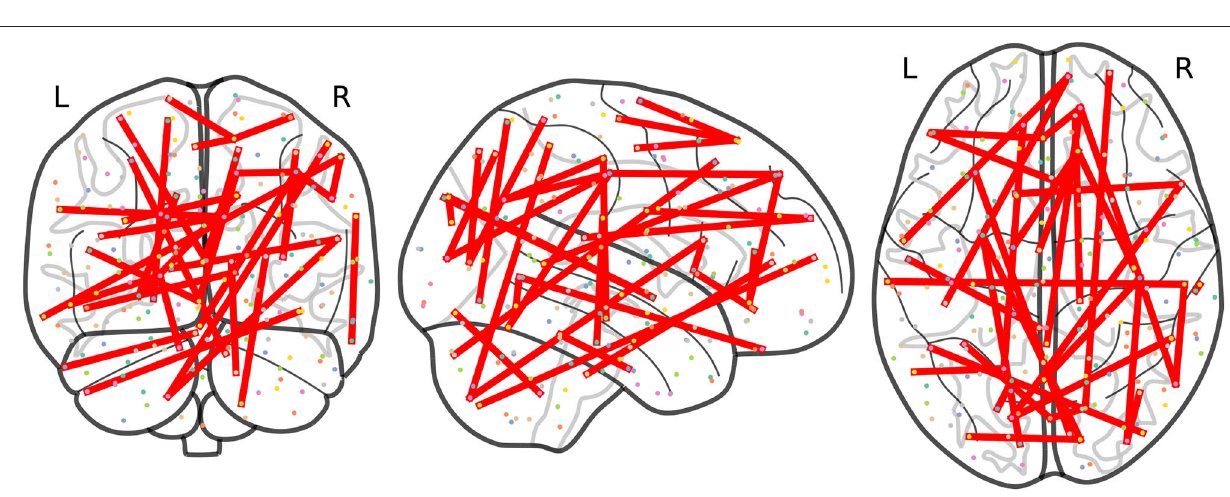
FIGURE 10 | Anomalous connections obtained by thresholding the frequency matrix for matrices harmonized under Rigid Log-Euclidean Translation to the global mean 6 at F ij ≥ 3. The 33 detected anomalies are